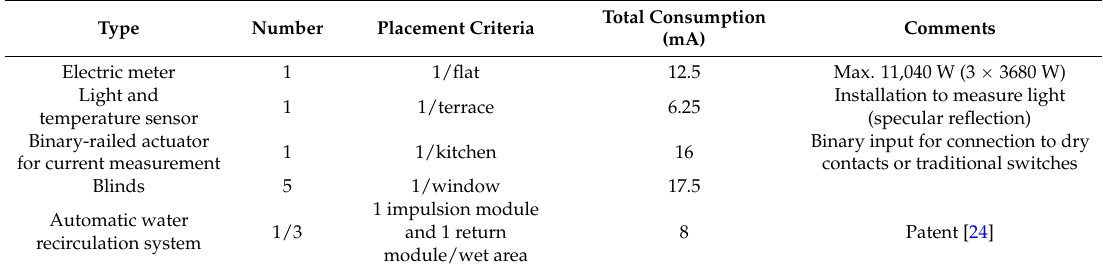
Table 4. Installed sensors and actuators in basic home automation system.